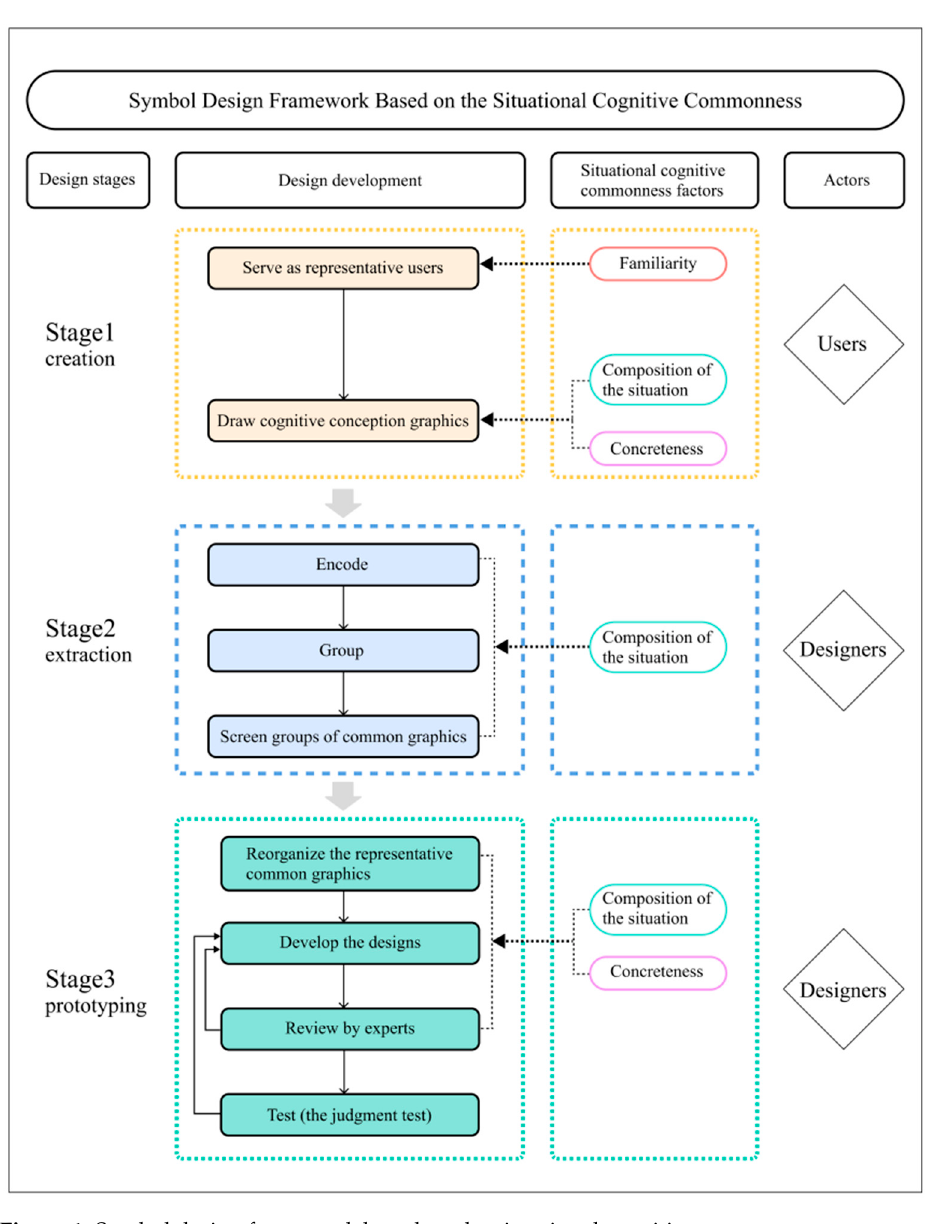
Figure 1. Symbol design framework based on the situational cognitive commonness.